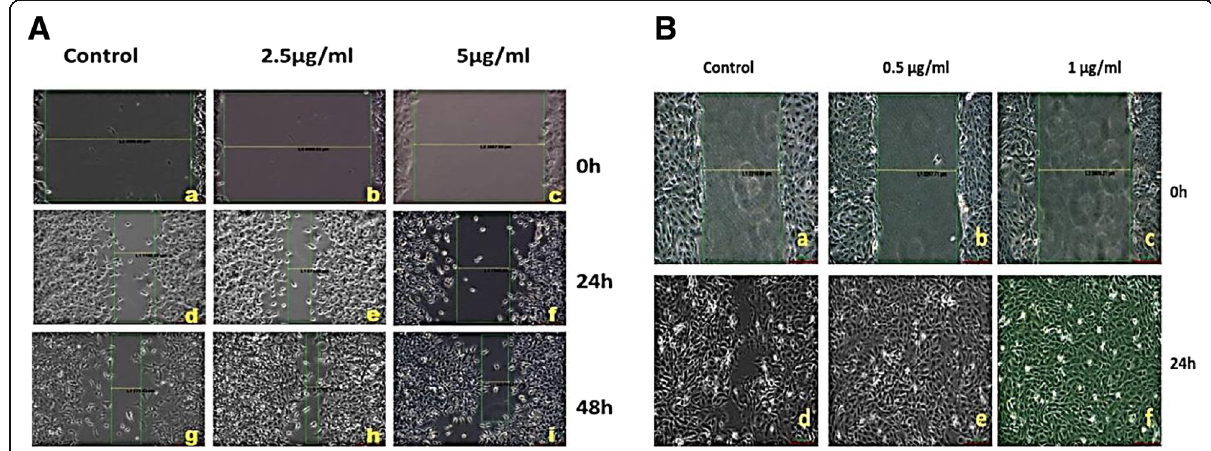
Fig. 11 Wound healing activity of AiP1 on HEK293 and HaCaT cells: A Wound healing was accelerated in AiP1-treated HEK293 cells compared to untreated cells which served as the control. Wound healing was observed at concentrations 2.5 and 5 μ g/ml of AiP1 (as seen in sections e, f, h, and i of A ). B Wound healing accelerated in HaCaT cells treated with AiP1 (sections b, c, e, and f of B ) compared to untreated cells (sections a and d of B ) which served as